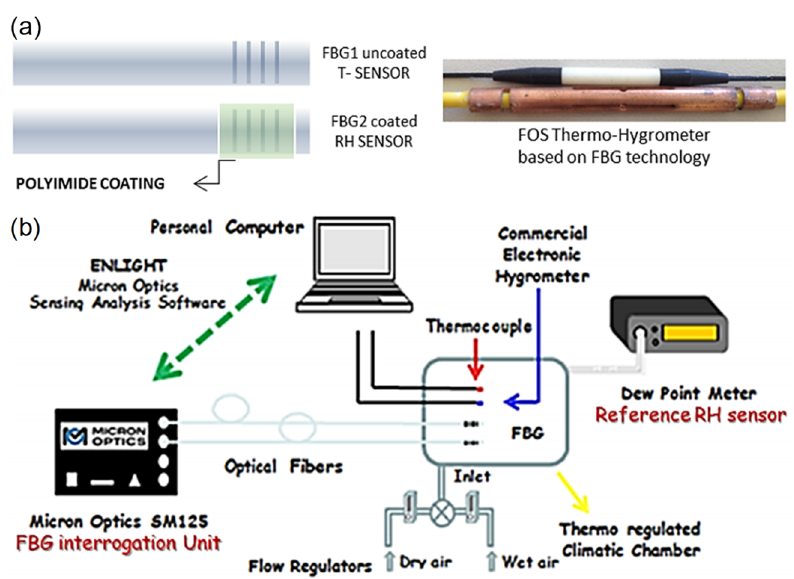
Figure 19. Point sensor. ( a ) Sensor head design and photograph. ( b ) Experimental setup. Adapted with permission from ref. [83]. Copyright 2014 IOP Science